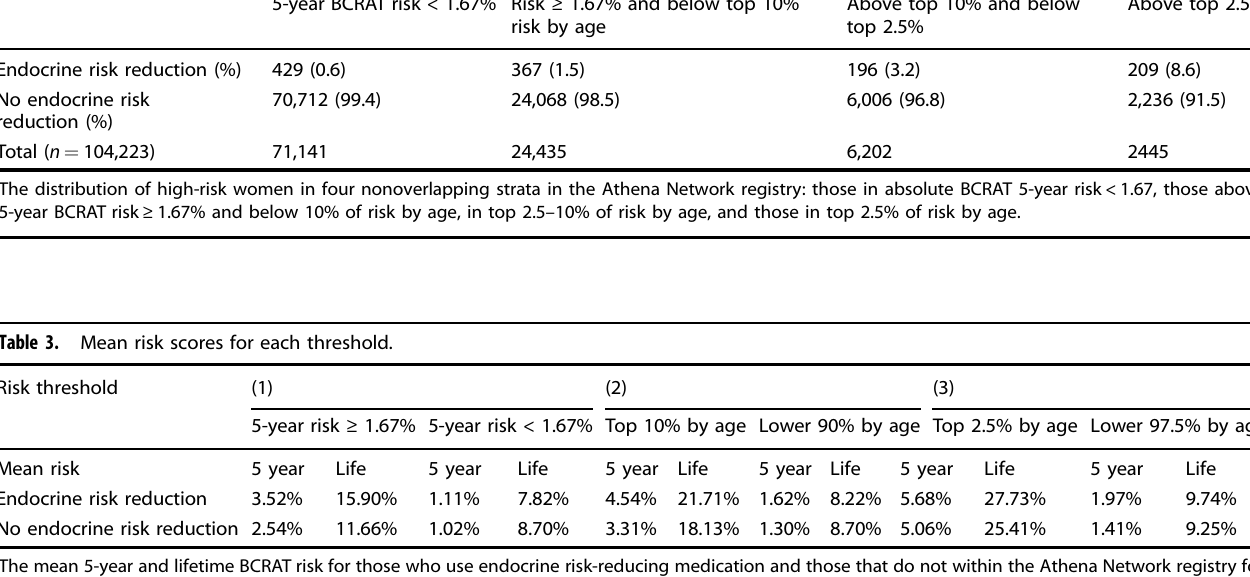
Table 2. Meeting threshold 1 was associated with nearly 4 times higher odds of adopting medication than if a participant did not meet